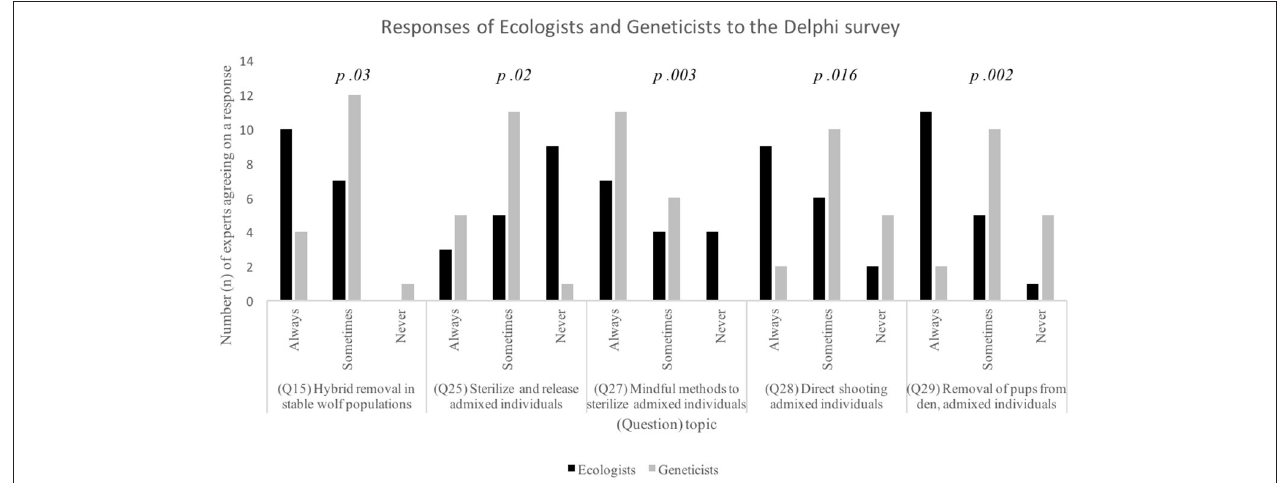
FIGURE 6 | Responses to a series of questions on wolf x dog hybridization by a selected group of experts, who self-identified themselves as either ecologists ( n = 17) or geneticists ( n = 17). The p -value in italics indicates that the responses of ecologists and geneticists were significantly different (Kruskal-Wallis Test). Ecologists were more supportive of reactive interventions and lethal removal than